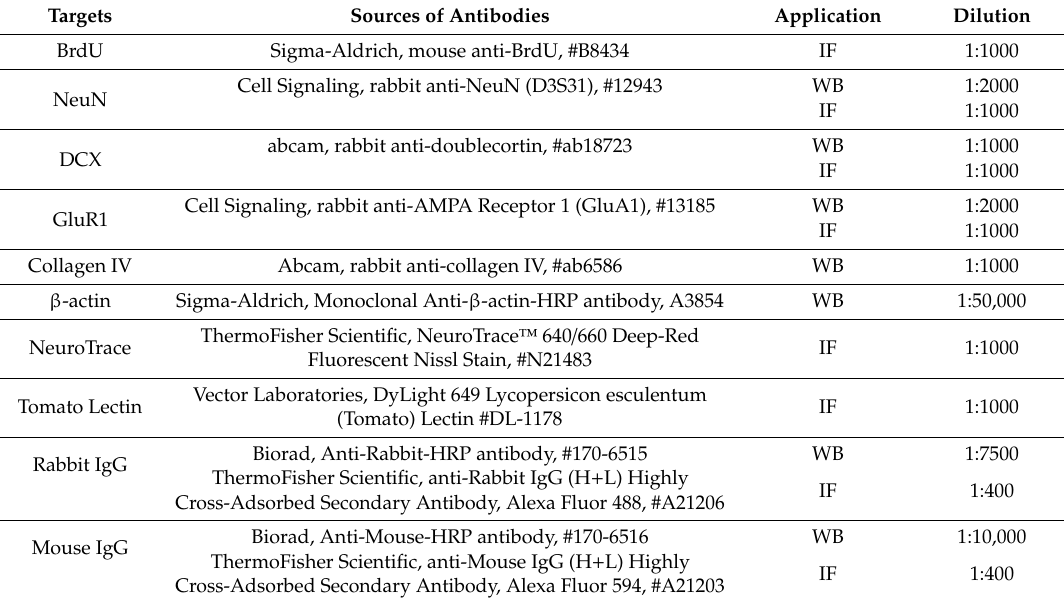
Table 1. List of antibodies used for western blot and immunofluorescence